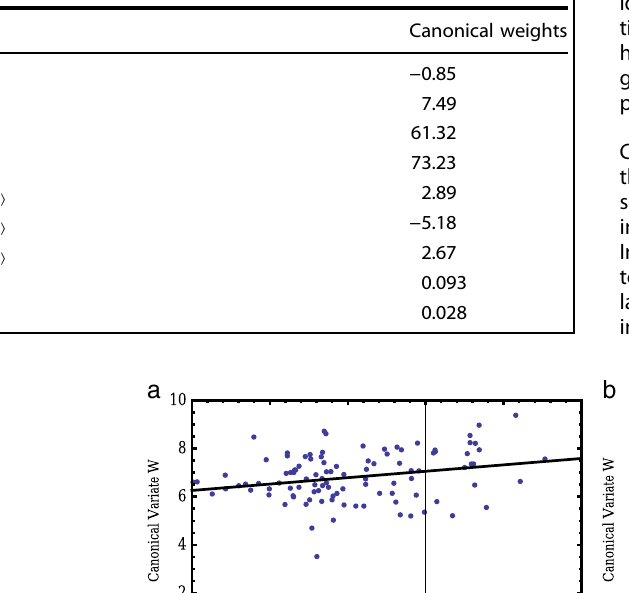
Table 1. The canonical weights and loadings, α i ( i = 1, 2, … , 7) and β j ( j = 1, 2), for the GBCD variables and the electrical and optoelectronic properties, respectively.